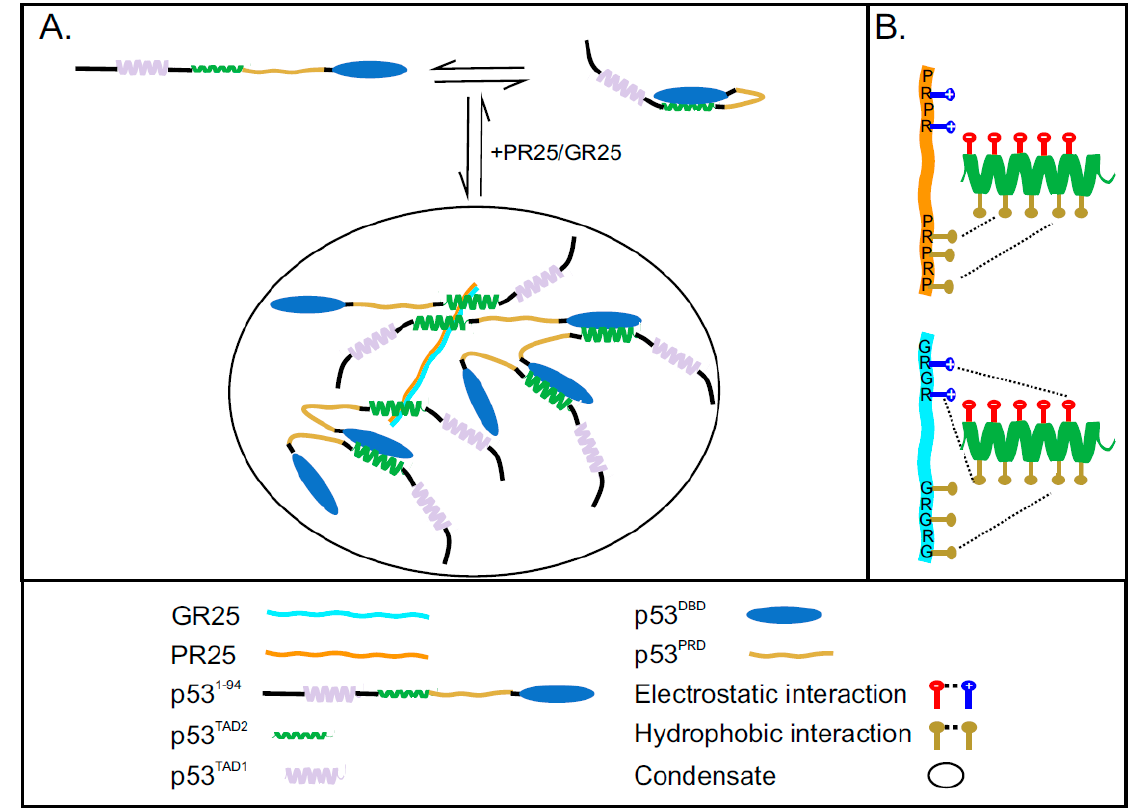
Figure 5. Interaction between p53 and PR25/GR25 is mediated by mainly TAD2 and phase separation of p53 is induced by PR25/GR25. ( A ) p53 is found in two forms, which are open and p53 DBD bound to p53 TAD2 (closed state, auto-inhibited) [64–66]. The addition of PR25/GR25 induces phase separation of p53, which is mediated by a combination of intermolecular interactions between p53 DBD and p53 TAD2 and intermolecular interactions between p53 TAD2 and PR25/GR25; ( B ) Schematic representation of the network of hydrophobic and electrostatic interactions between p53 TAD2 and